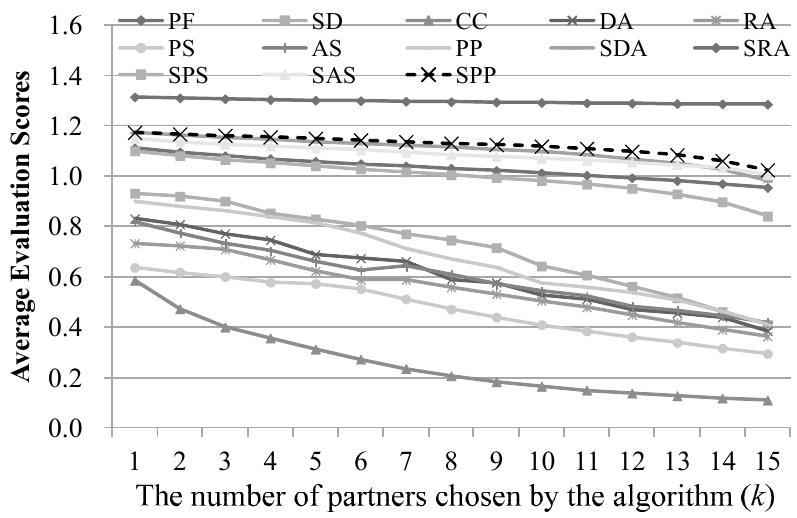
Figure 12. Average evaluation scores of various methods.